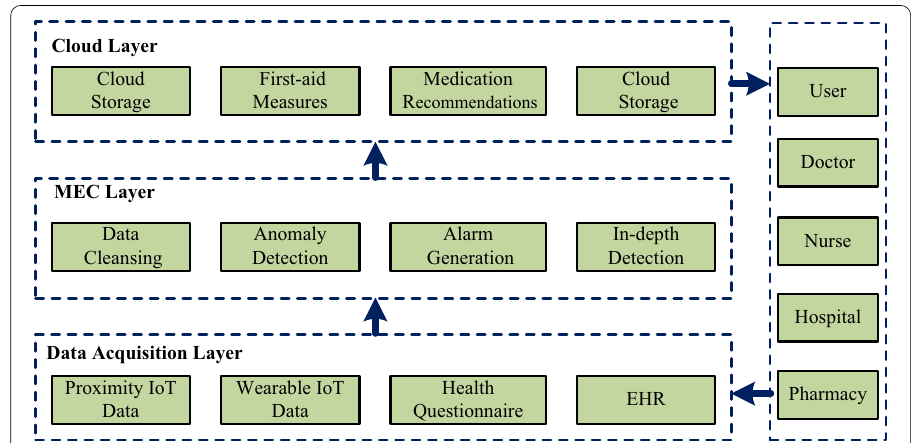
Fig.2 The framework of the real-time big data healthcare analysis